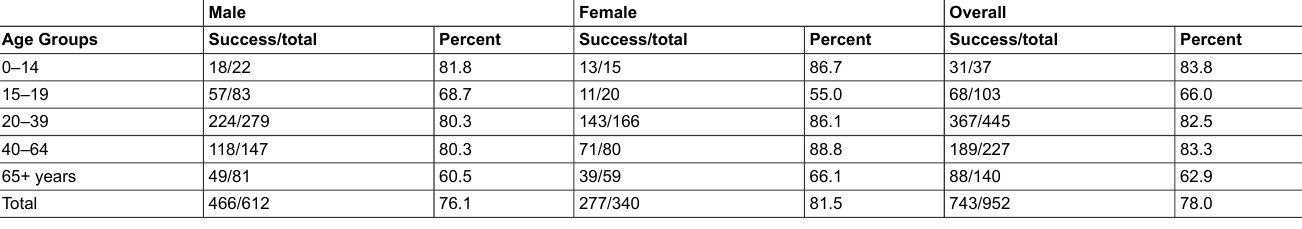
Table 5: Treatment success according to the WHO (cured or treatment completed) among pulmonary culture-positive rifampicin-susceptible tuberculosis cases, Switzerland and Liecht- enstein, 2016–2018. Male Female Overall Age